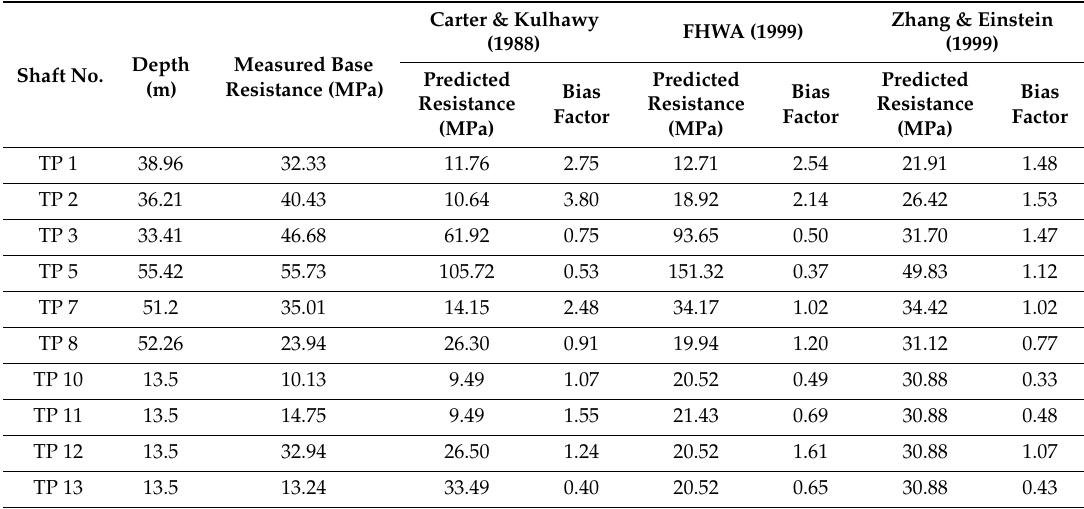
Table 7. Calculated bias factors for base resistance.